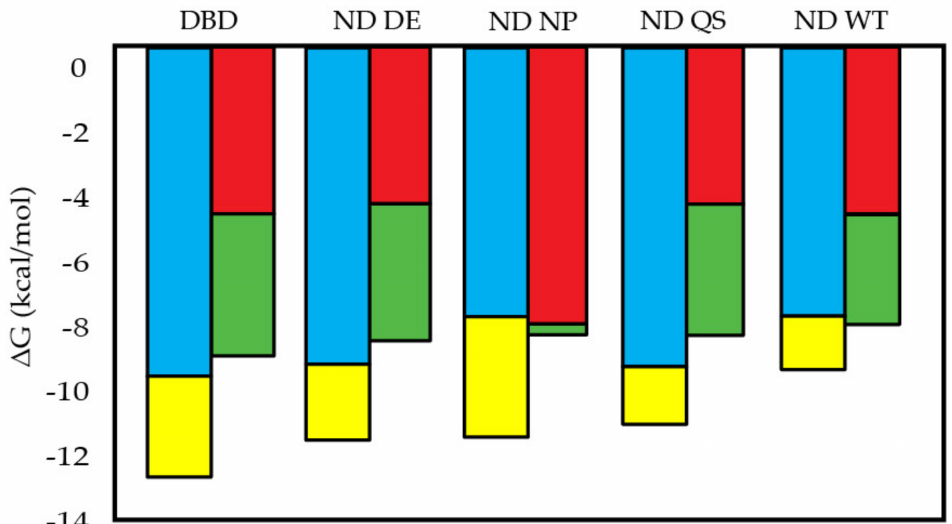
Figure 7. Salt-dependent and salt-independent components of Gibbs free energy at 145 mM IS from Record’s model. Free energy is apportioned into categories by assuming complete inhibition of salt-dependent components at 1M NaCl so the remainder of free energy is salt-independent. Slopes of double log plot slopes are used to estimate binding affinity at 1M NaCl, where is the salt-dependent component and is the salt-independent component for consensus DNA and is the salt-dependent component and is the salt-independent component for scrambled